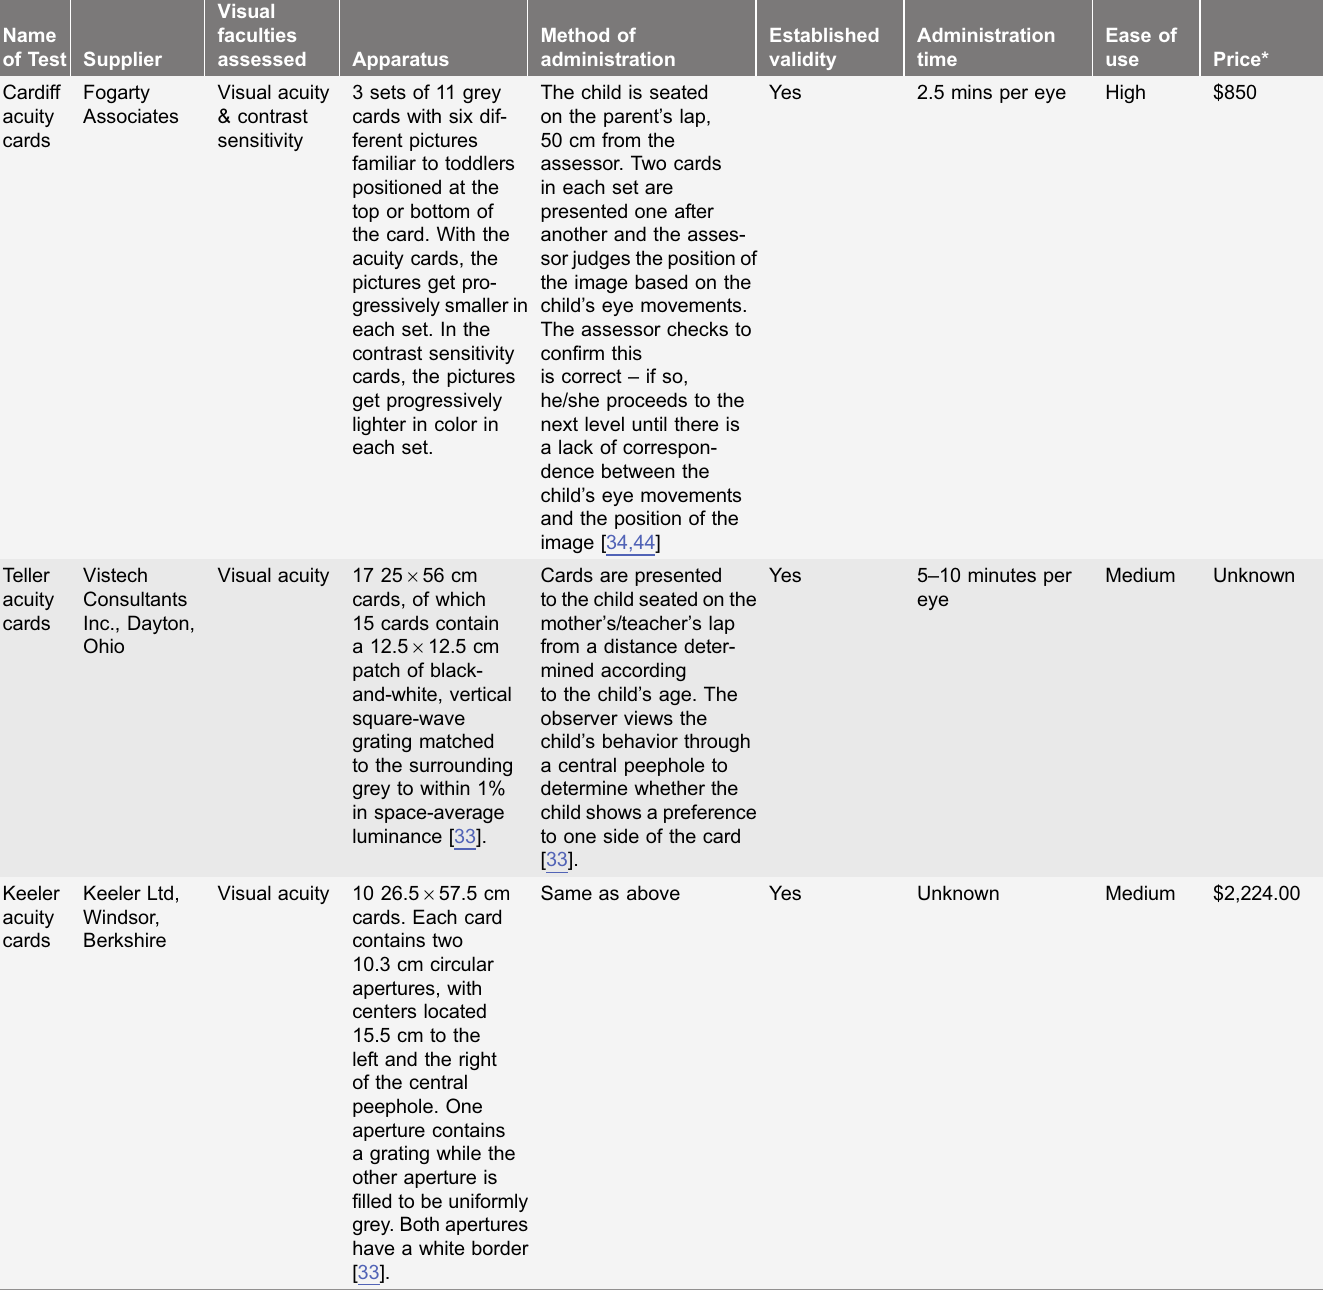
Table 7. Analysis of candidate FPL techniques to assess vision in young